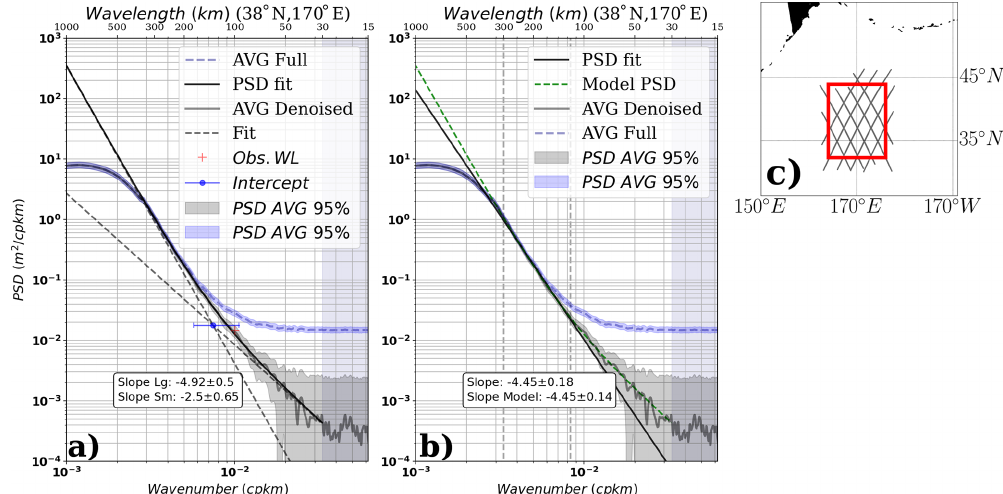
Figure 3. (a) Result of the double-slope methodology used to characterize the spectral shape over the unbiased power spectral density (PSD) (full gray line). The original and unbiased PSD (dashed blue and gray lines) and the 95% confidence interval of the average PSD (blue and gray shading) are shown. The mesoscale and small-scale spectral slope fits (dashed black), combined double-linear-fit model (full black), and the L t intercept of large- and small-scale spectral slopes (blue dot, including its uncertainty) are also illustrated. (b) Single mesoscale fit method, as in Vergara et al. (2019). As a reference, the result of the PSD fit from (a) is also plotted (dashed green line). Unbiased average PSD (full gray line) and 95% confidence for the average estimate (gray shading) analyzed using the wavelength range depicted by the vertical dashed lines to characterize the spectral slope. Average spectral slopes and their corresponding 1 σ values are indicated in the inserts. (c) Zone where the average PSD sample is computed from J3 data over